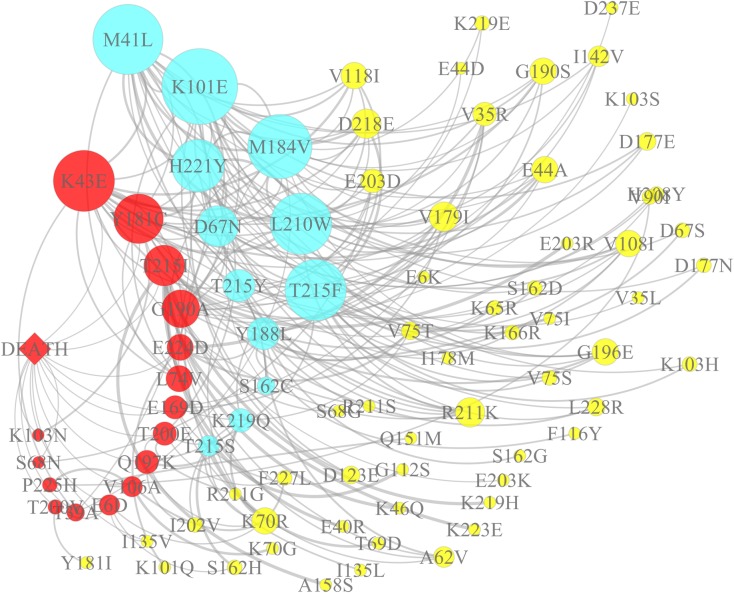
Interactive network of death-associated polymorphisms and other mutations.The network represents the global relationship among the death-associated polymorphisms and other mutations. The death-associated polymorphisms are highlighted in red, the drug resistance mutations are highlighted in green, and all other mutations are yellow. In the network, the size of the node represents the mutation frequency of that site from one amino acid to another, while the width of the line represents the strength of the influence between two mutations.